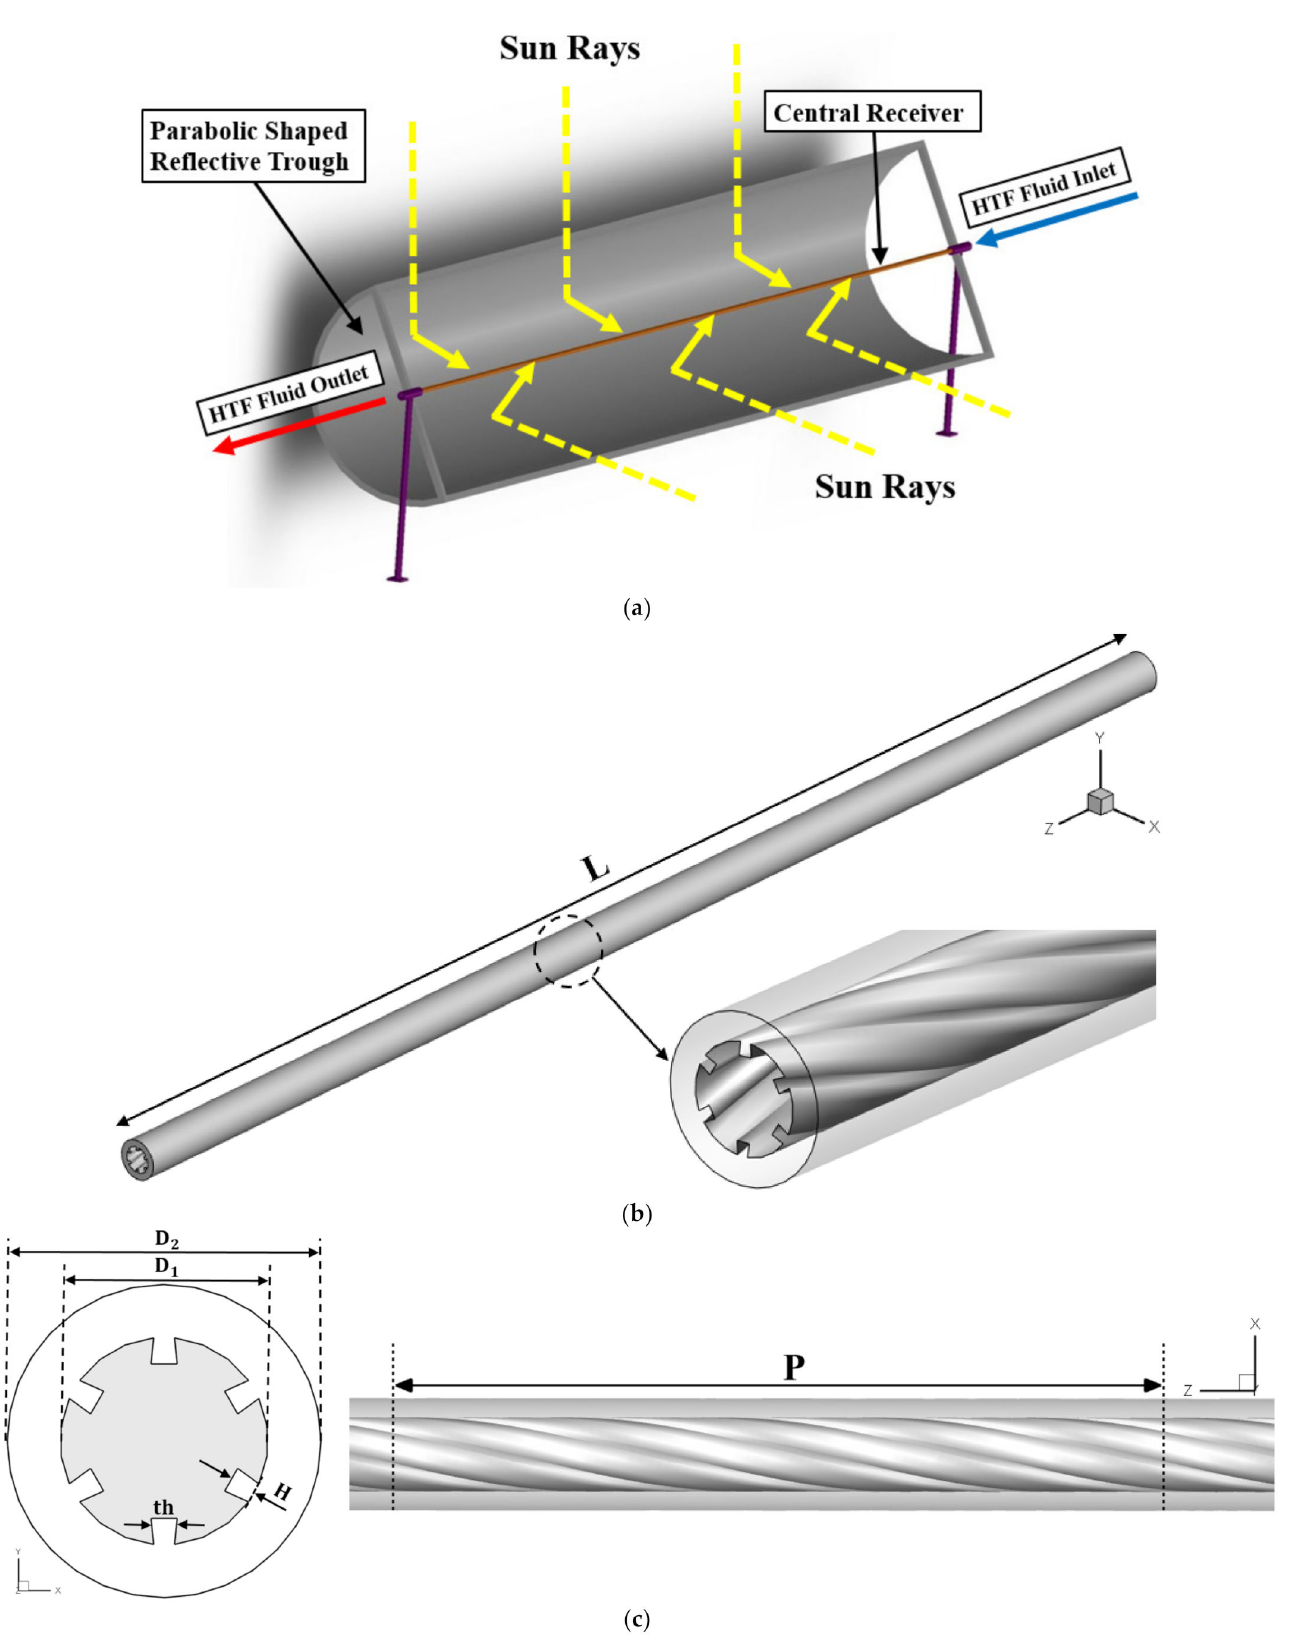
Figure 1. ( a ) A schematic of the PTC structure, ( b ) the schematic of the considered pipe and the inner helical axial fins, and ( c ) the geometrical